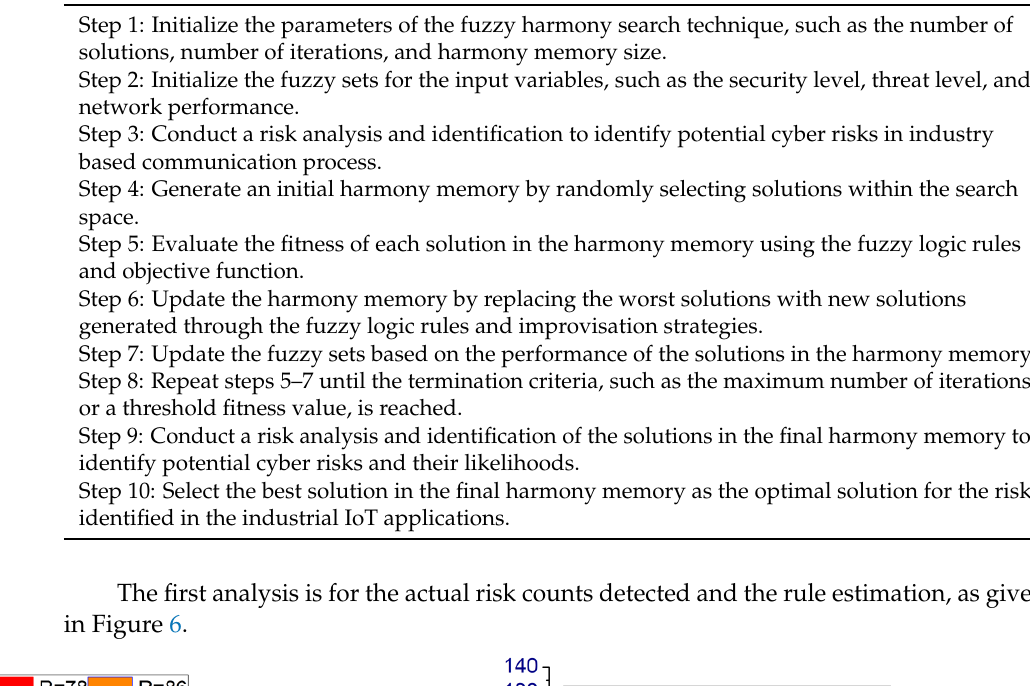
Table 1. Fuzzy harmony search based risk identification.